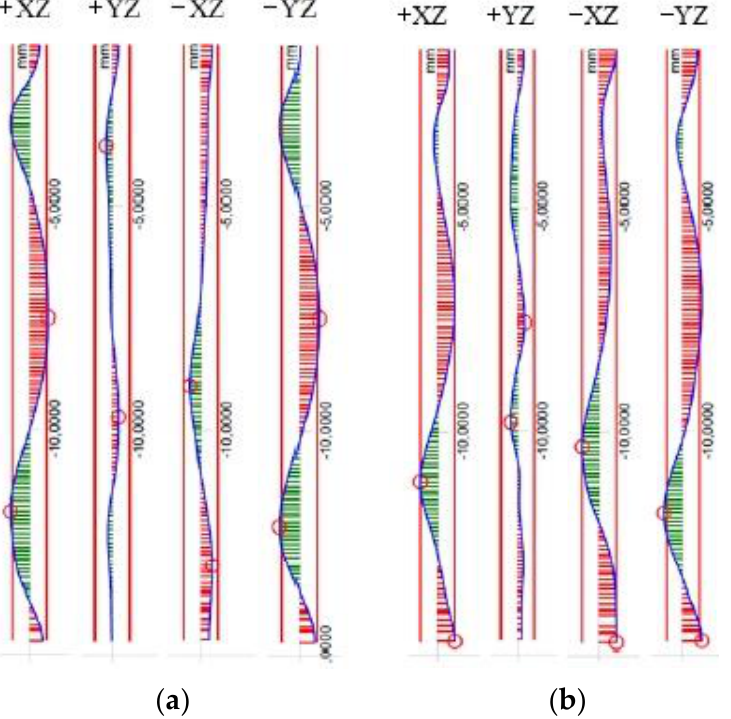
Figure 21. Straightness deviations ( a ) constant stepover-pocket Auto border; ( b ) spiral strategy. Measured straightness deviations are described in Table 5. Table 5. Measured straightness deviations.